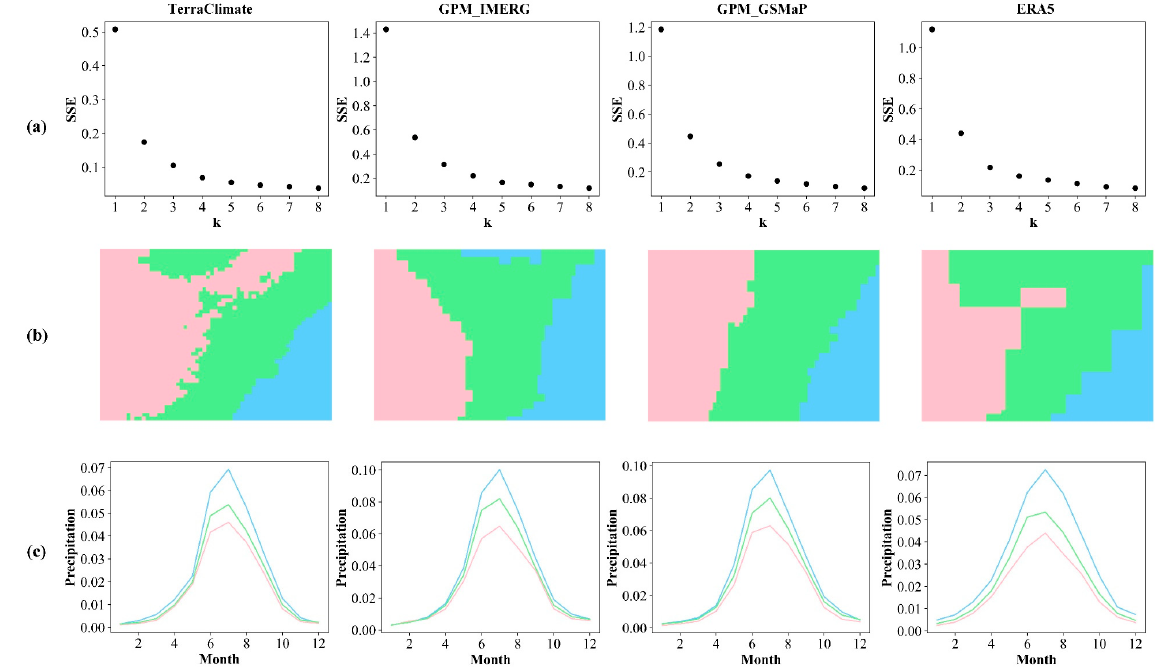
Figure 3. Scatter plot of SSE and cluster numbers ( k ) of four sets of precipitation data ( a ), the spatial distribution of clustering results ( b ), and the multi-year averaged monthly precipitation of each subregion ( c ).